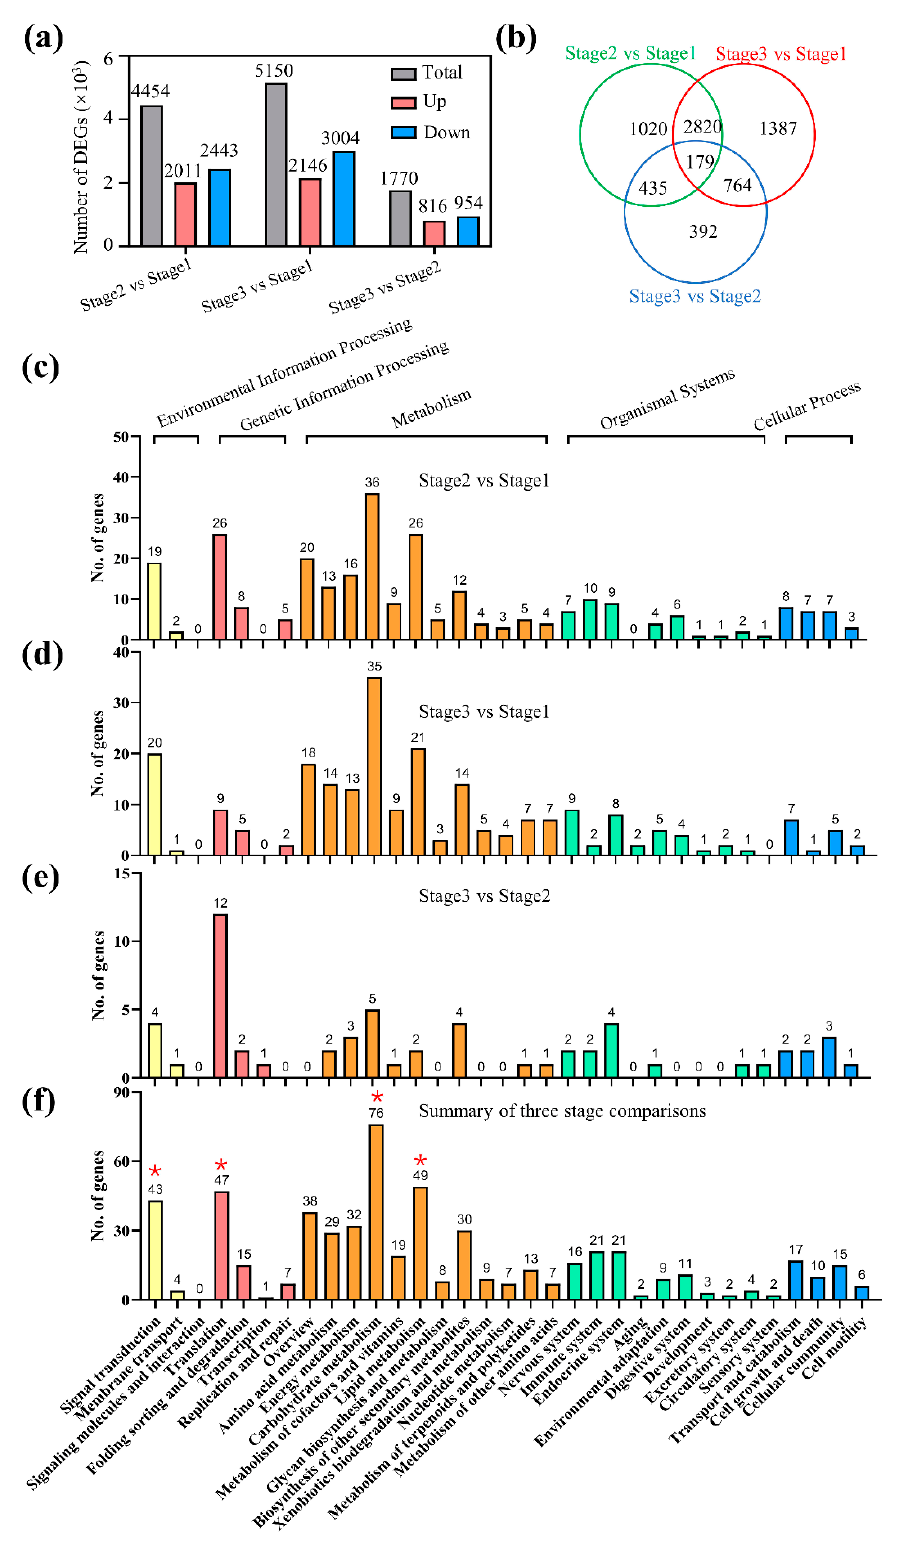
Figure 3. KEGG enrichment of differentially expressed genes. ( a , b ) Summary of differentially expressed genes at stage 1, stage 2, and stage 3. KEGG pathways enrichment in ( c ) stage 1 to stage 2, ( d ) stage 1 to stage 3, ( e ) stage 2 to stage 3, and ( f ) three germination stages. * means the genes were focused on in the following study.